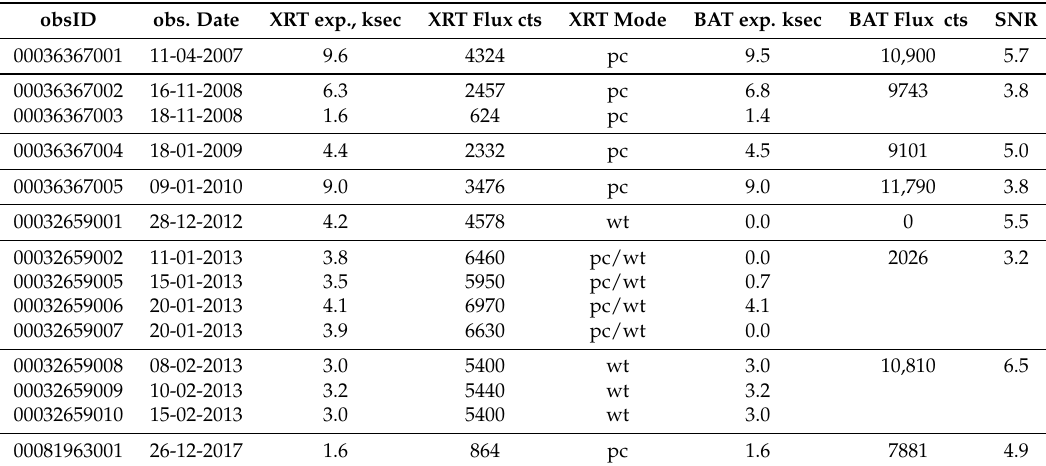
Table A2. SWIFT (XRT and BAT) observations LOG.